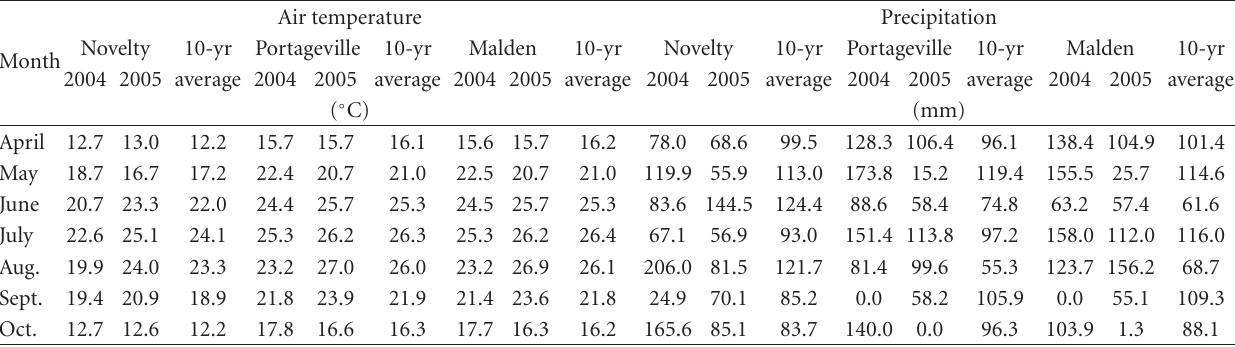
Table 2: Mean monthly air temperature and precipitation at Novelty, Portageville, and Malden in 2004 and 2005 growing seasons and 10-year average (2000 to 2009).